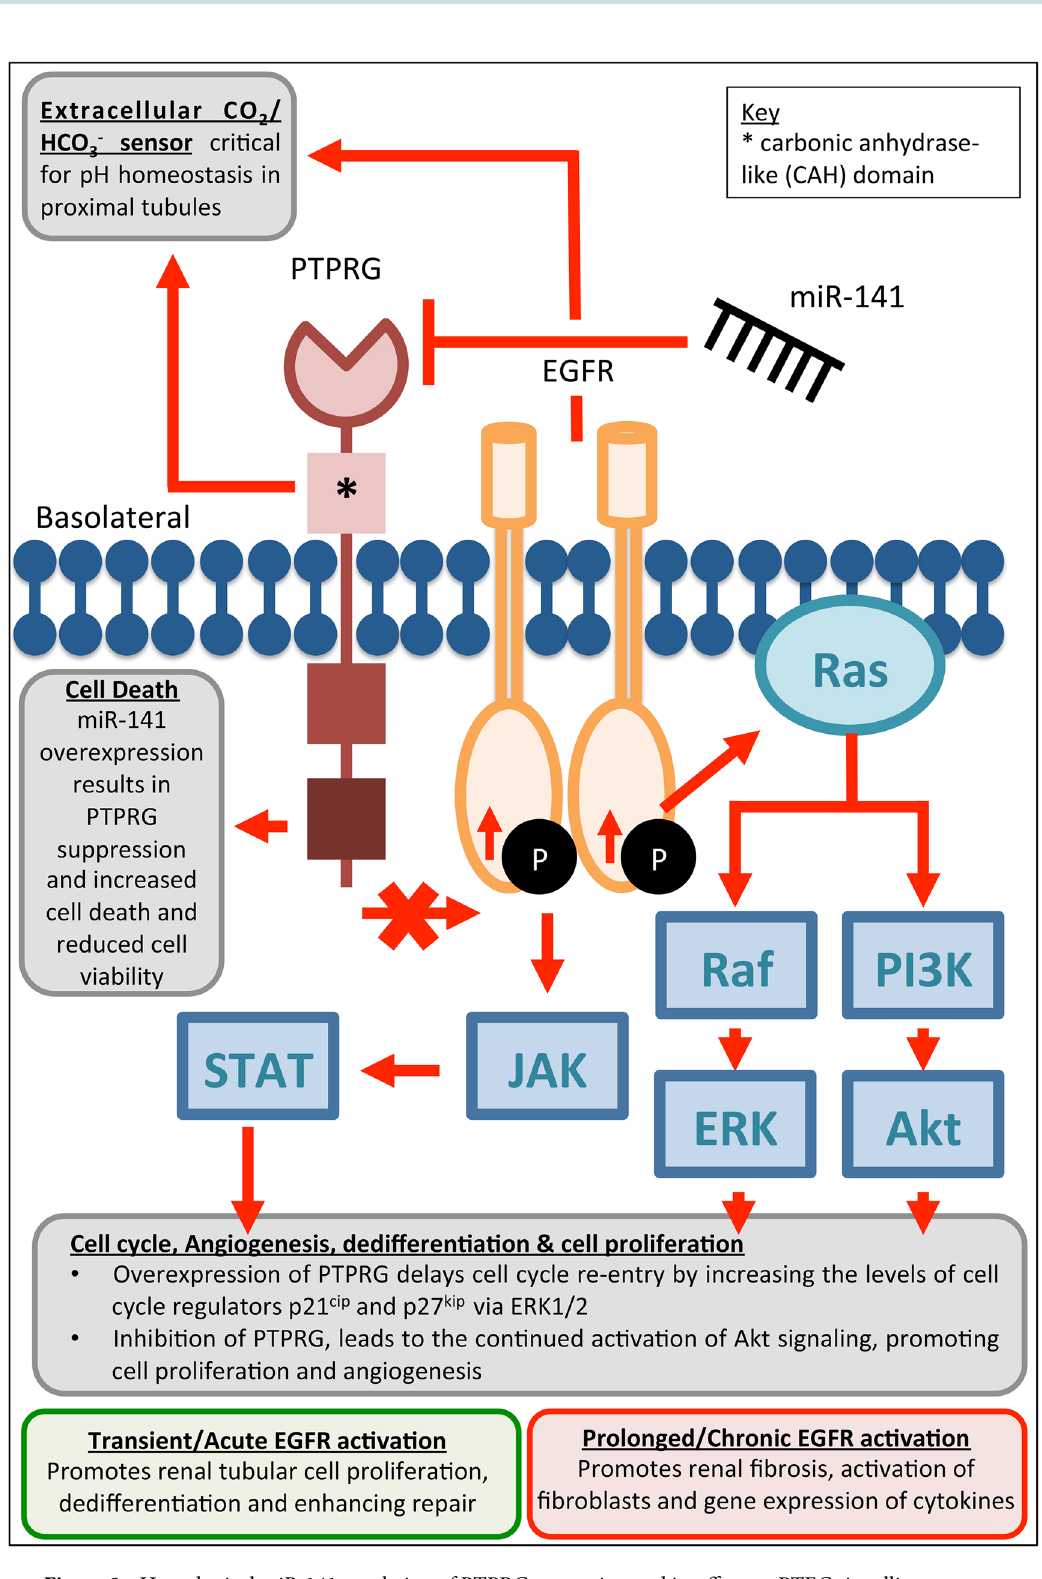
Figure 8. Hypothetical miR-141 regulation of PTPRG expression and its effect on PTEC